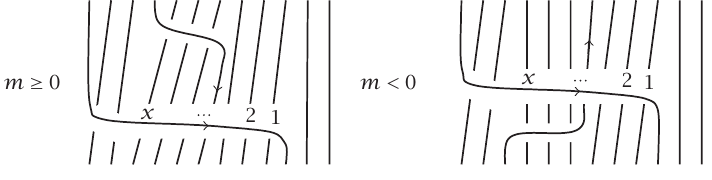
= 0 ∈ (cid:1) Σ × I) . 0 ( 2 k